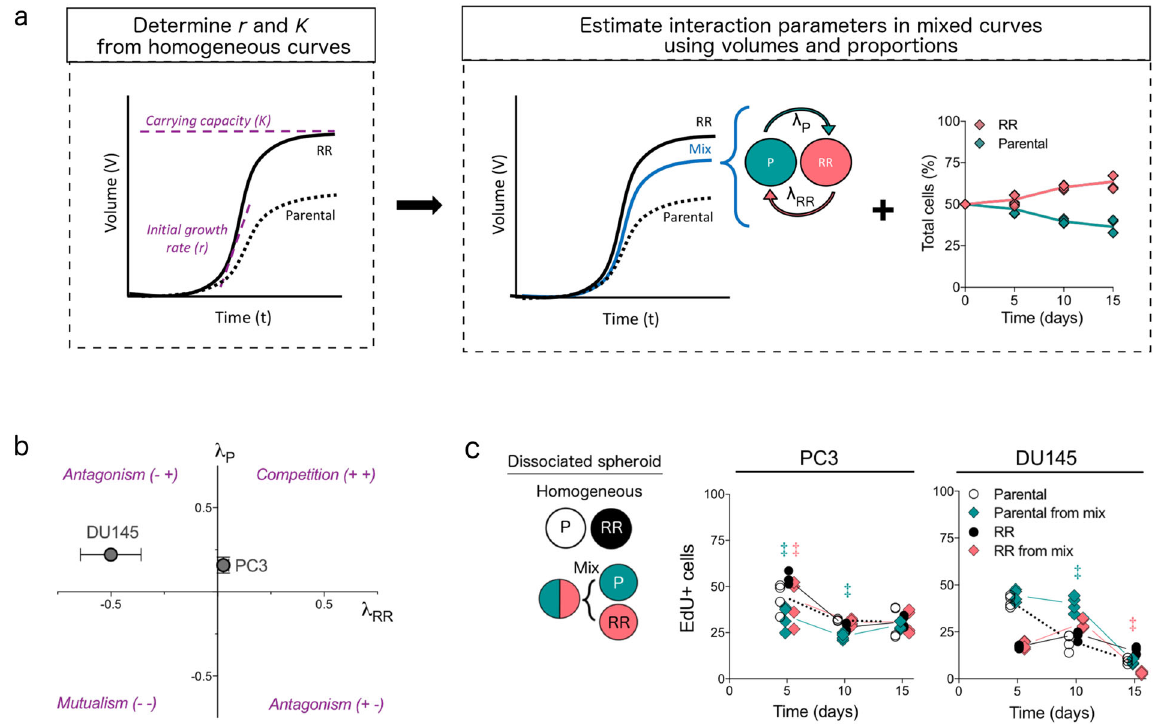
Fig. 3 Mathematical modelling predicts the type of ecological interactions in unirradiated mixed prostate spheroids. a Schematic illustrating pipeline for mathematical modelling of ecological interactions. The logistic model of spheroid growth was fi t to growth curves of homogeneous PC3 and DU145 spheroids to determine the growth rate r and carrying capacity K (the limiting volume of the spheroid) for parental and radioresistant populations. Interaction parameters in mixed curves were then estimated by fi tting volume measurements and proportions of each population to a Lotka – Volterra model. The parameter λ P indicates the effect of parental on radioresistant, while the parameter λ RR indicates the effect of radioresistant on parental. b Estimated interaction parameters using biological data of mixed PC3 and DU145 spheroids. The nature of the interaction, i.e., competition vs. antagonism, depends on the sign of the interaction parameters. Error bars represent con fi dence intervals. c Experimental determination of proliferation (EdU + cells) from cell cycle analysis for parental and radioresistant (RR) cell populations isolated from mixed (parental, green diamonds; RR, pink diamonds) and homogeneous spheroids (parental, white circles; RR, black circles; n = 4 experiments). Lines connecting symbols indicate the median value. ‡ FDR < 0.05, overdispersed Poisson regression model fi tting with Benjamini – Hochberg correction.